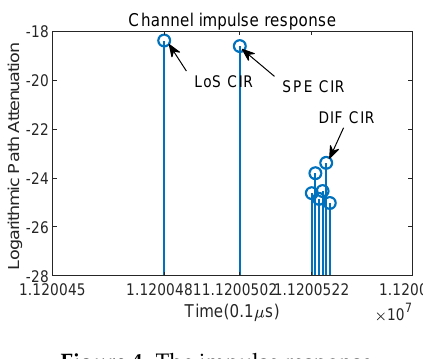
Figure 4. The impulse response.